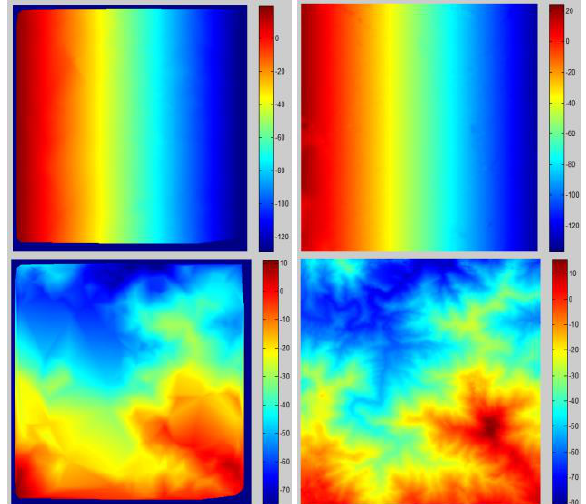
Figure 4. Deformation in across-flight direction (top row) and along-flight direction (bottom row). The left column is produced by the parameterized method while the right column is from the non-parameterized one proposed in this study.